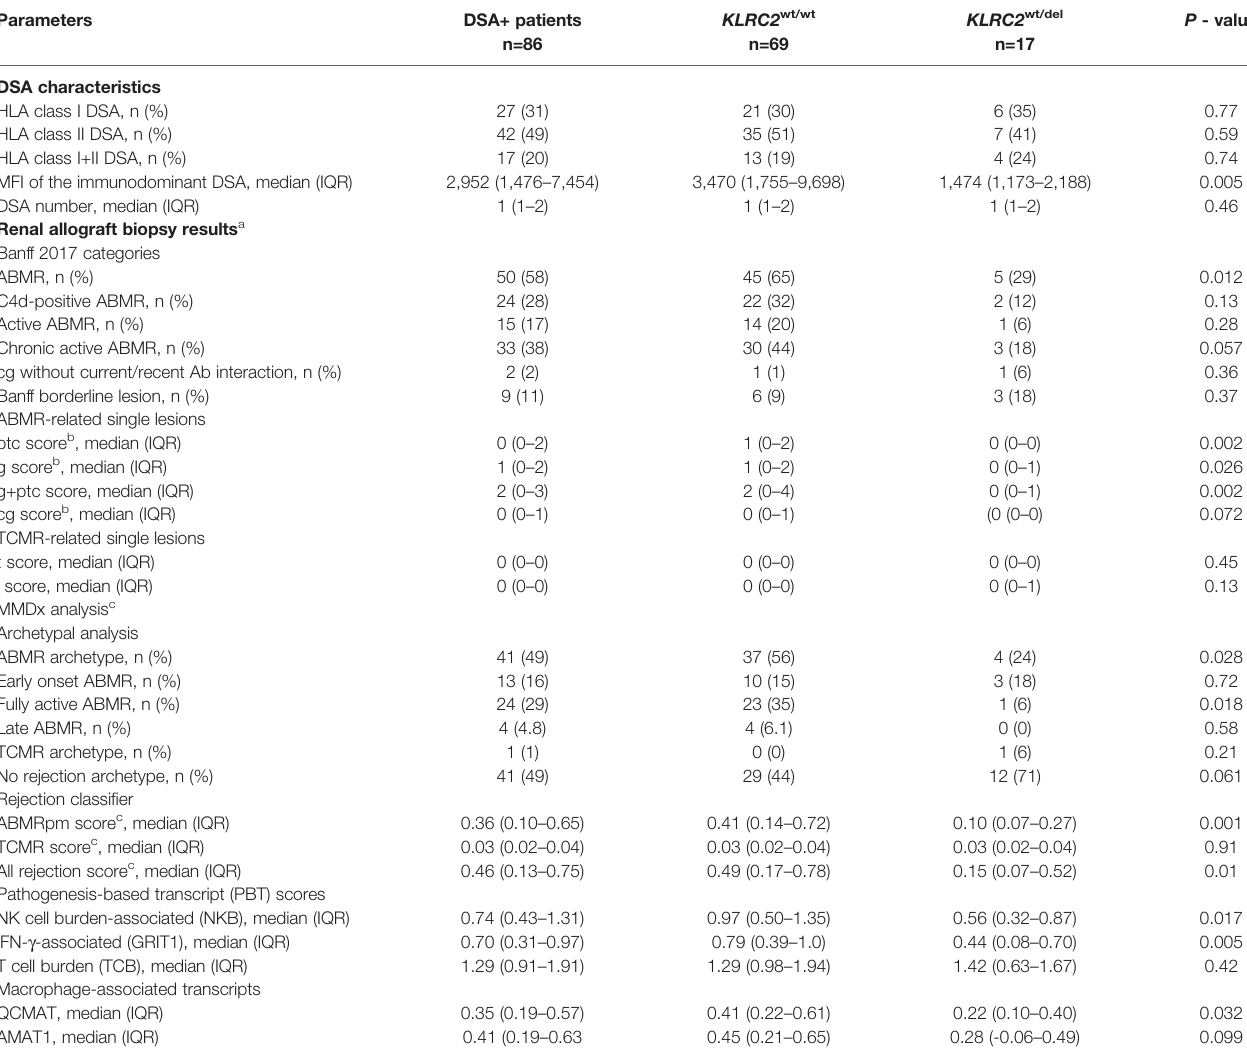
TABLE 3 | Rejection-related parameters – cohort 1